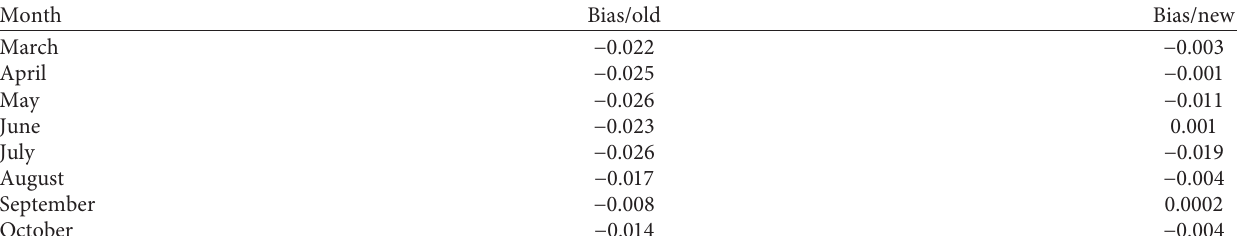
Table 2: Biases between the monthly average surface albedo simulations before and after assimilation and the observations (simulation minus